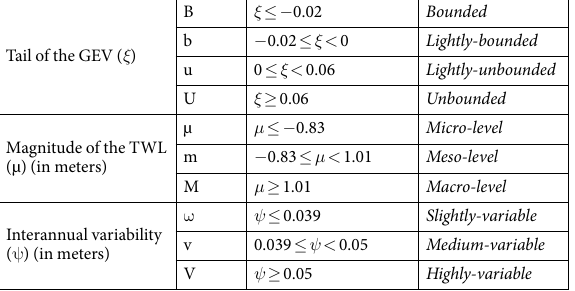
Table 1. Thresholds for the GEV parameters. Threshold selection to obtain discrete categories according to the location, scale and shape parameters of the GEV